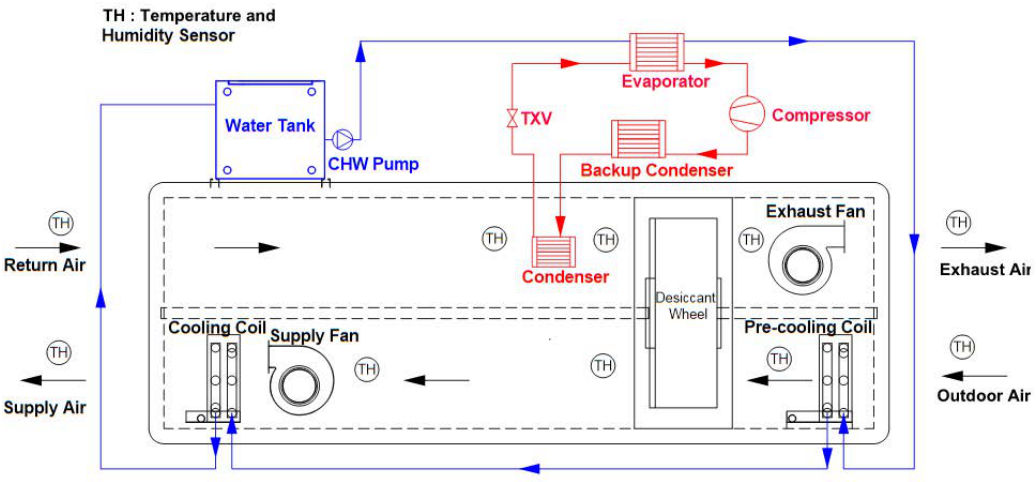
Figure 1. Hybrid solid desiccant cooling system (SDCS)